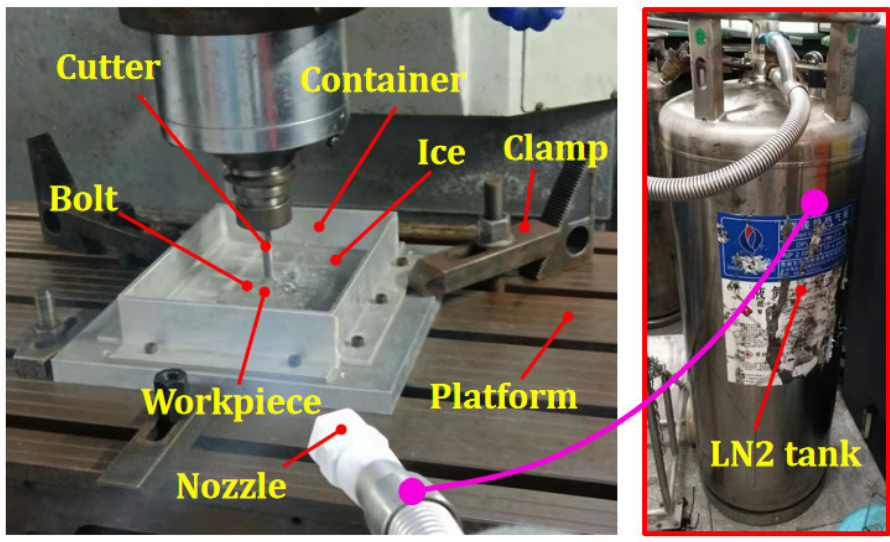
Figure 7. Experiment setups. Table 8. Experimental design.